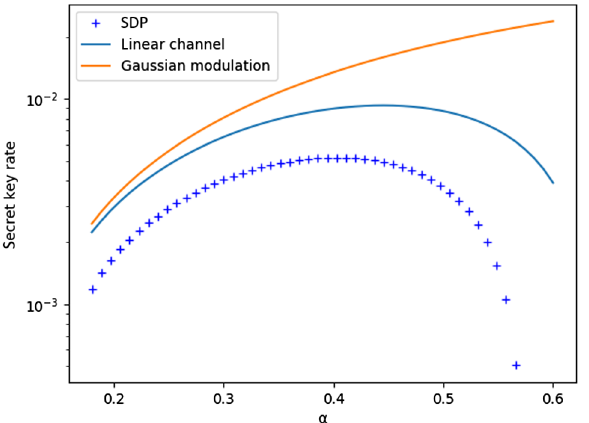
FIG. 3. Secret key rate versus distance, for a Gaussian channel with transmittance T ¼ 10 − 0 . 02 d and excess noise ξ ¼ 0 . 005 . Other parameters are the same as in Fig. 2.